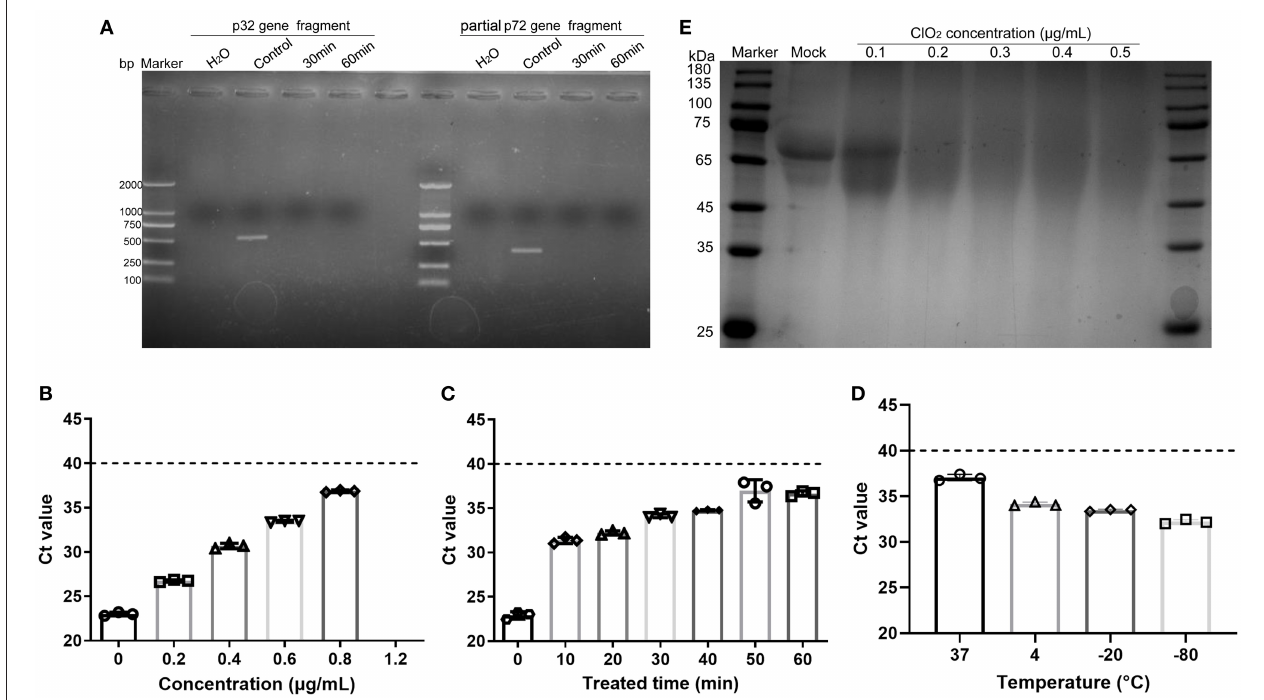
FIGURE 7 | ClO 2 inactivation of ASFV virions may due to its effects on viral nucleic acids and proteins. (A) ASFV was incubated with ClO 2 at the indicated concentration for 30 or 60min at 37 ◦ C, the fragments of virus p32 gene (558 bp) and partial p72 gene (478 bp) were amplified by PCR to test the viral nucleic acids damage by ClO 2 . The starting amount of ASFV added to each reaction is 5.8 × 10 6 copies. (B–D) To determine the minimum concentration at which ClO 2 destroys the viral nucleic acids and the effect of ClO 2 in killing ASFV in various temperature, different concentrations of ClO 2 were incubated with ASFV for 30min at 37 ◦ C (B) , or ClO 2 at the indicated concentration was incubated with the virus at 37 ◦ C for various times (C) or at different temperature for 60min (D) , the mixtures were then collected and quantitative PCR was performed to measure the level of viral p72 gene. The threshold cycle (Ct) values which are below the cut-off (dashed line) mean ASFV-positive. (E) The effects of ClO 2 on the viral proteins were also tested. ClO 2 at different concentrations was incubated with ASFV for 30min at 37 ◦ C, the mixtures were subjected to SDS-PAGE analysis. Data are representative of the results of three independent experiments (means ±